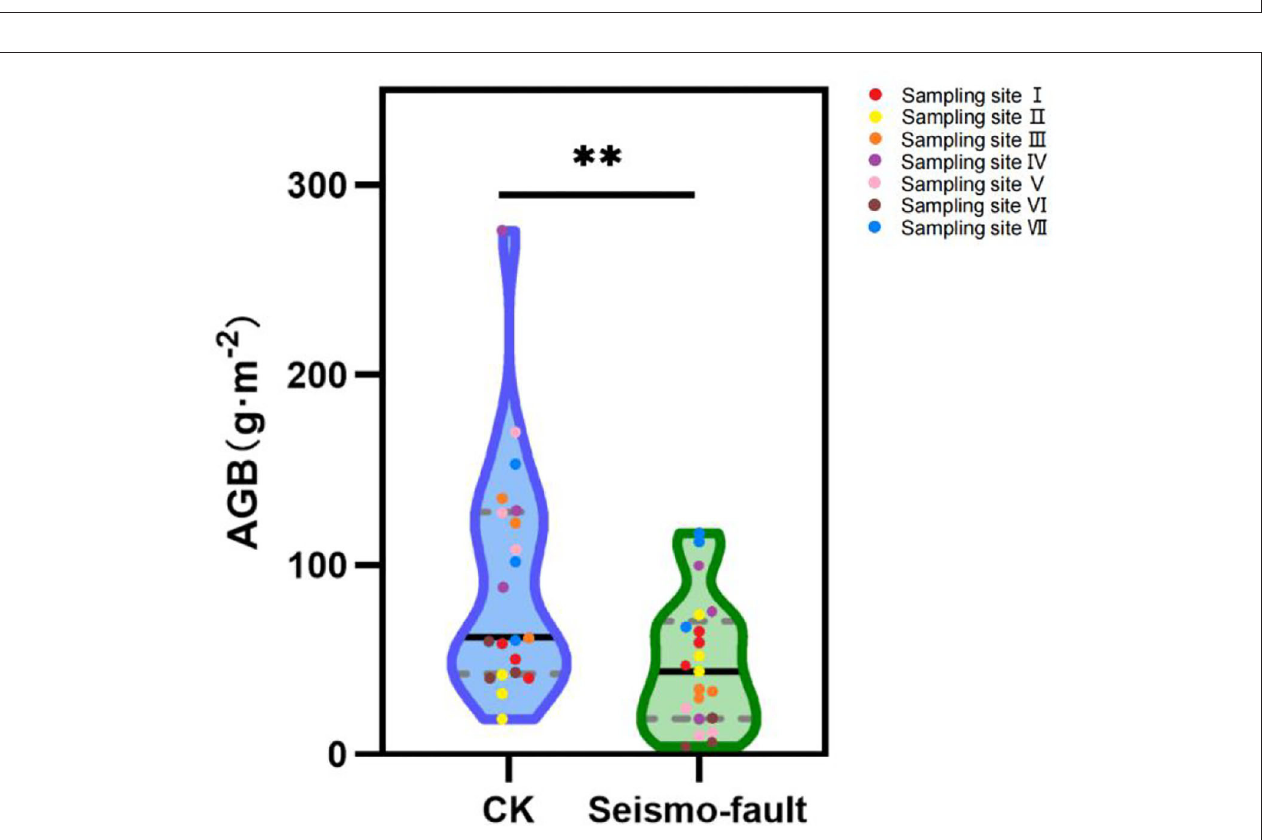
FIGURE 5 | Aboveground biomass in different seismic regions. Asterisks indicate differences among treatments (** p < 0.01). Different colors represent different sampling sites.